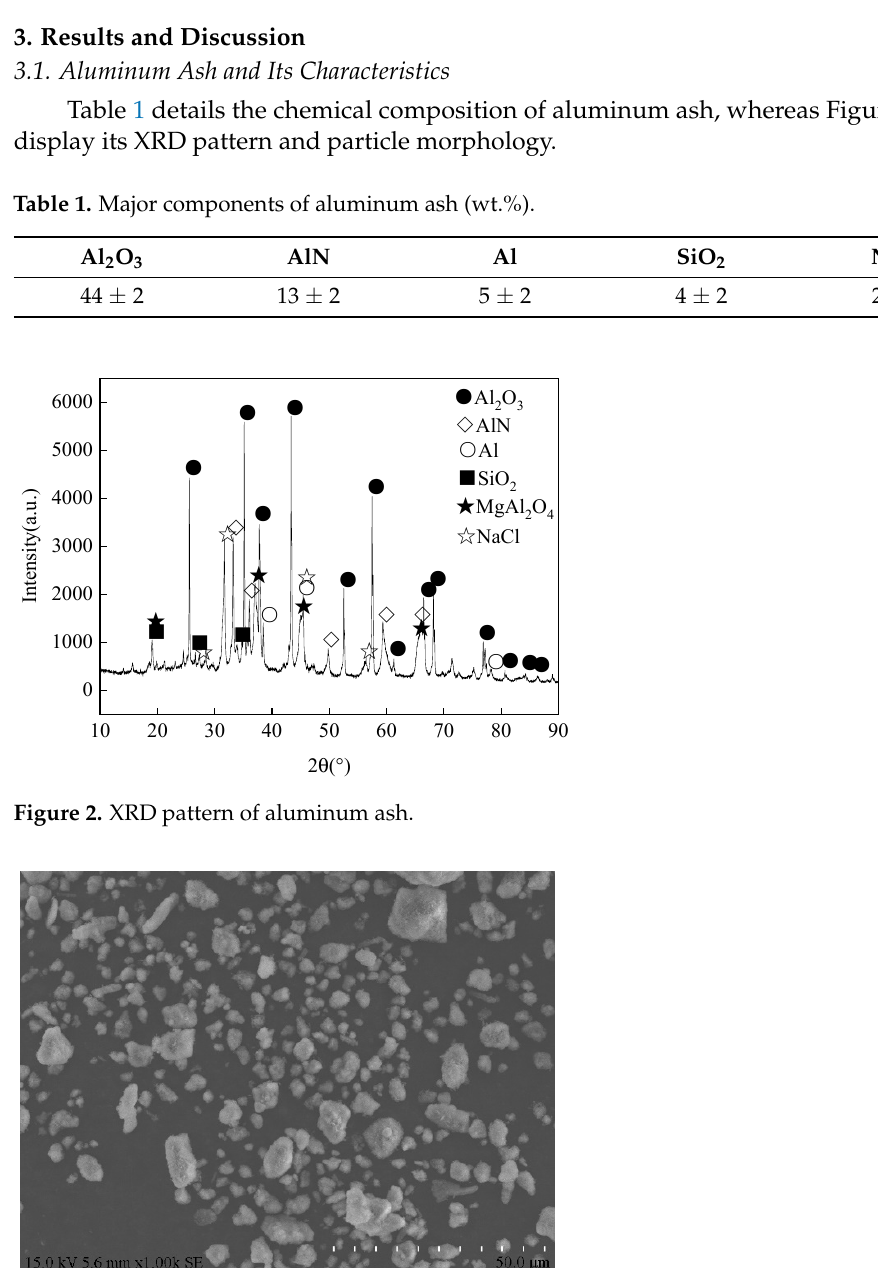
Figure 1. Sample preparation flow chart.